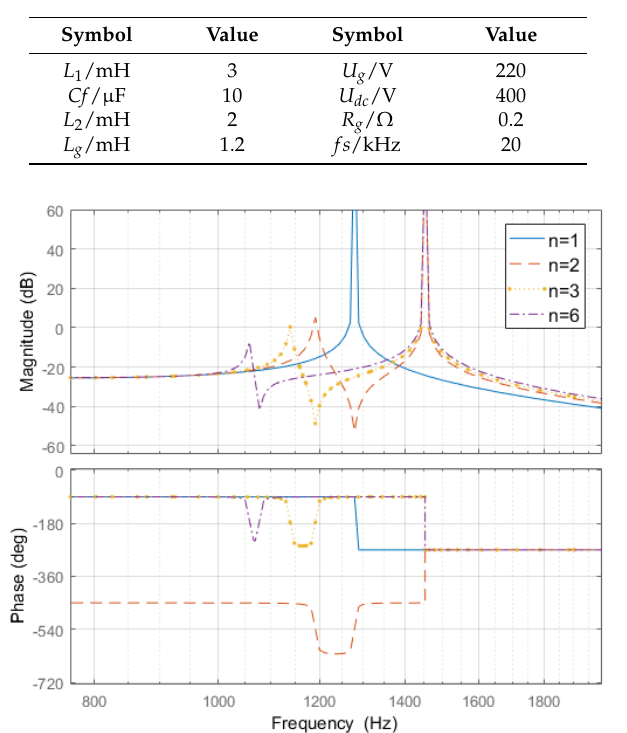
Table 1. Parameters of the HCGIs system.